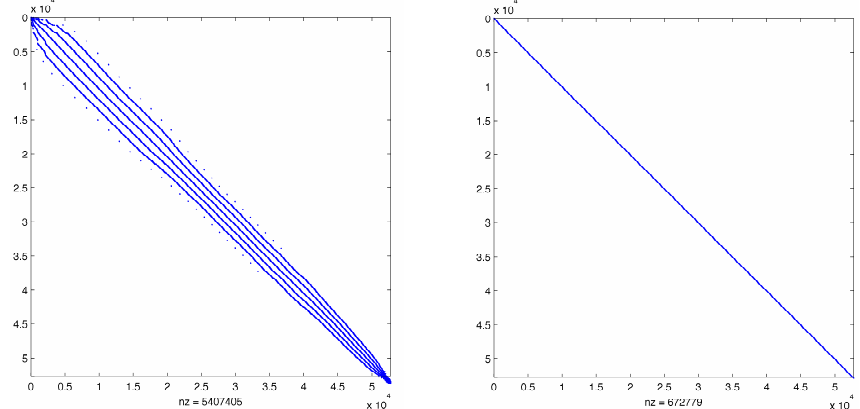
Fig. 1. One block of the explicit (left) and implicit (right) transport matrices A exp , A imp computed using the MITgcm for a 2.8125 ◦ resolution